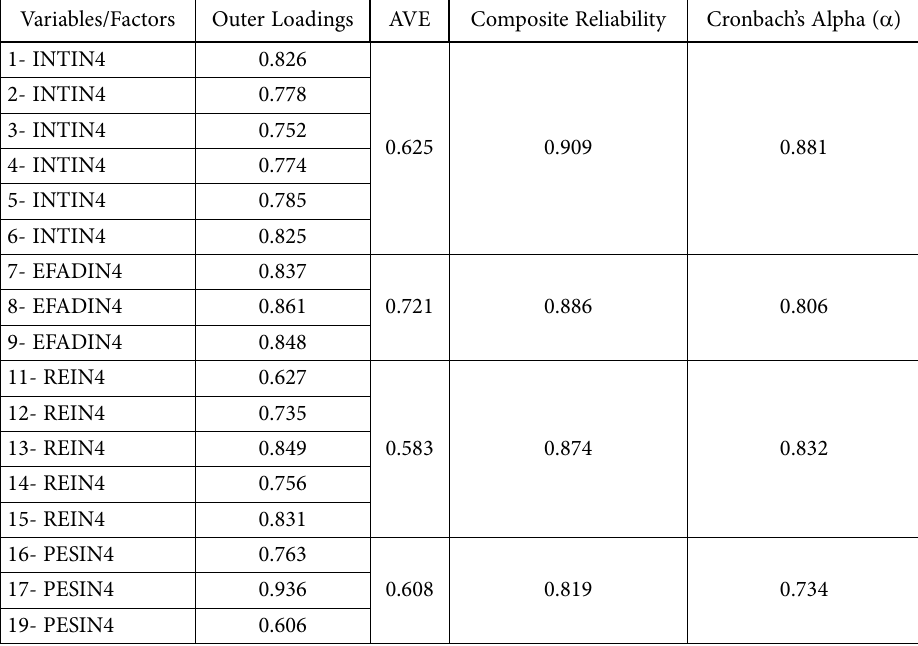
Table 8. Convergent validity values Variables/Factors Outer Loadings AVE Composite Reliability Cronbach’s Alpha ( α